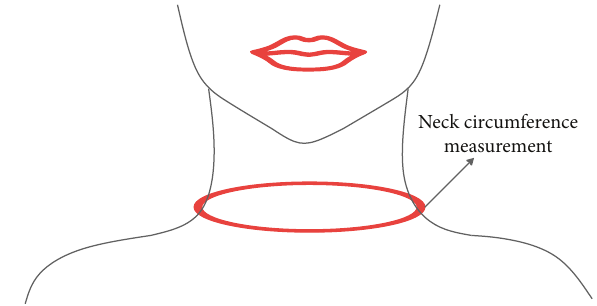
Figure 5: Neck circumference measurement chart.